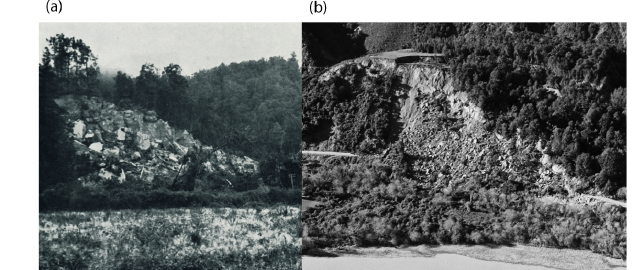
Figure 6. (a) 1968 Oweka rock slide with rock debris (Lensen and Suggate, 1968). (b) 1968 rotational slide of ∼ 2 million m 3 in sandy (“Blue Bottom”) mudstone. At the top of the landslide the semi- intact block below the prominent head scarp has slumped about 6m. The main body of the slide has carried the rock downslope and com- prises highly disrupted mudstone boulders and finer